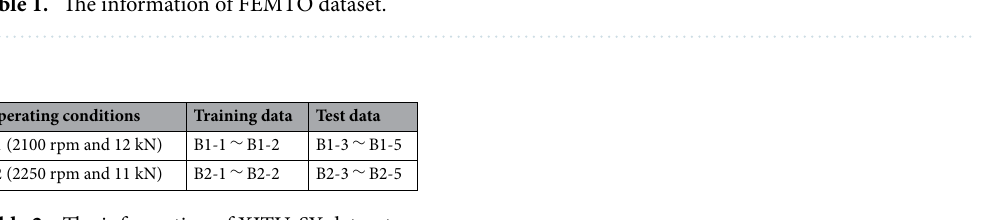
Table 2. The information of XJTU-SY